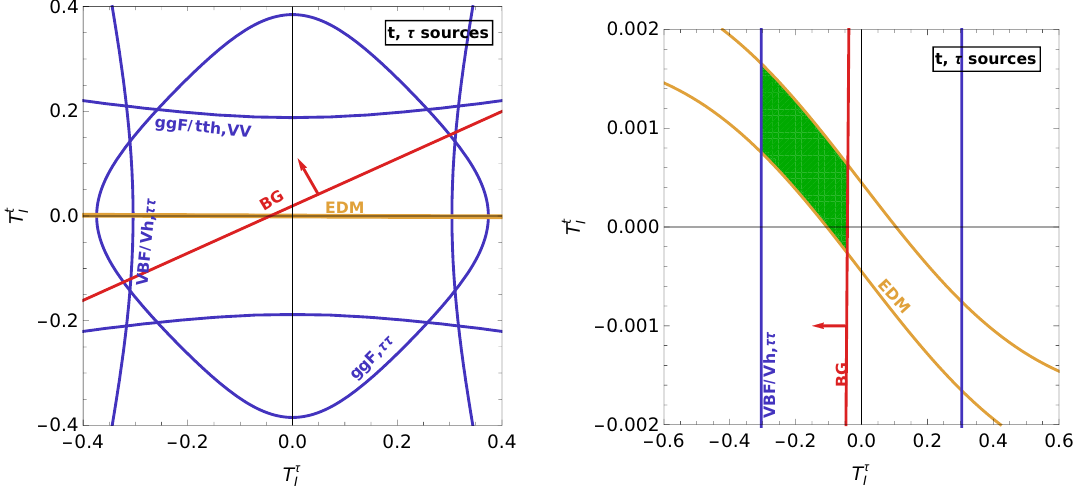
Figure 4 . Constraints on t and (cid:28) sources with T t;(cid:28) = 0 from the LHC (blue), the eEDM (yellow) R and Y B (red). The parameter space allowed by all three constraints is highlighted in green. Left: full collider range allowed by (cid:22) (cid:28)(cid:28) = 0 : 99 (cid:6) 0 : 44 and (cid:22) (cid:28)(cid:28) = 1 : 09 (cid:6) 0 : 26 (combining ATLAS ggF VBF+ V h and CMS), right: zoomed into the EDM-allowed region.